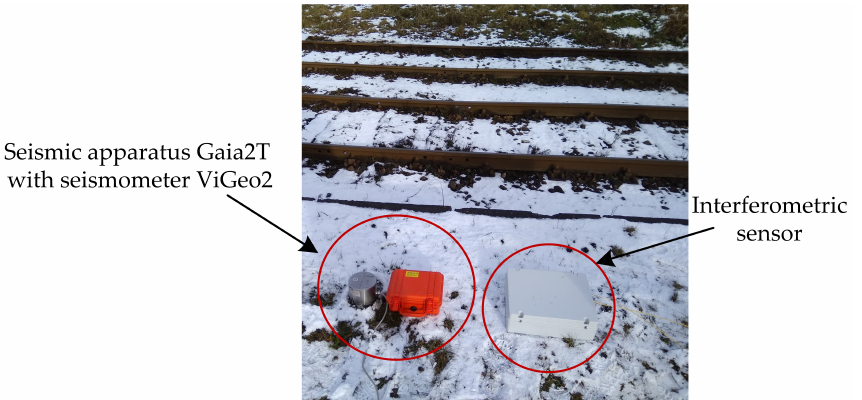
Figure 8. Example photo of placing both types of sensors taken during the tram measurements in